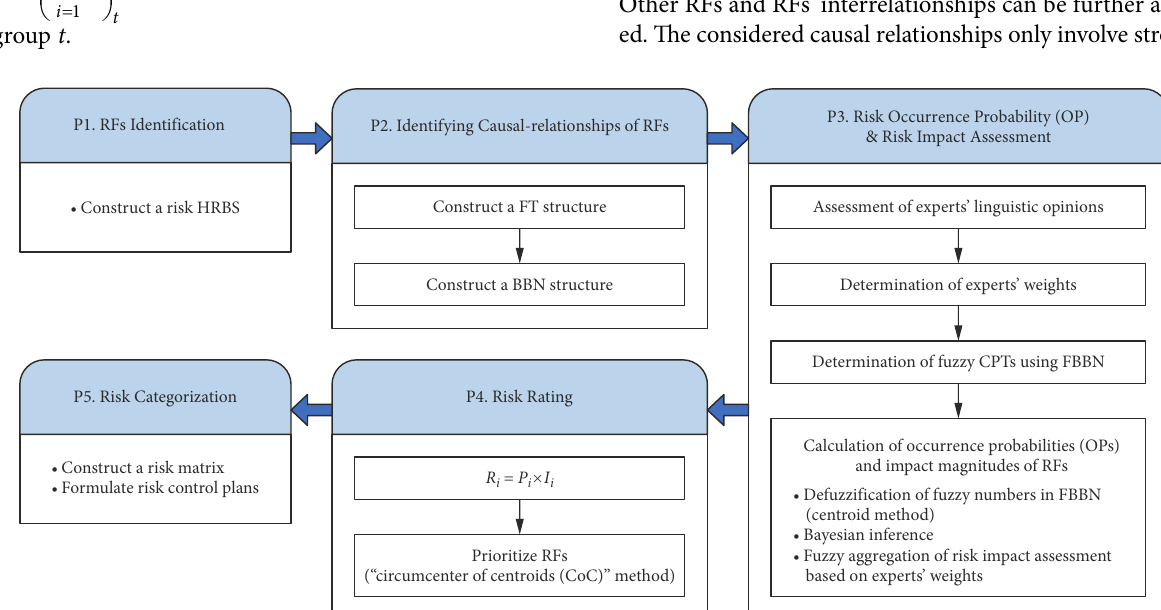
Figure 3. The FBBN-based RA model